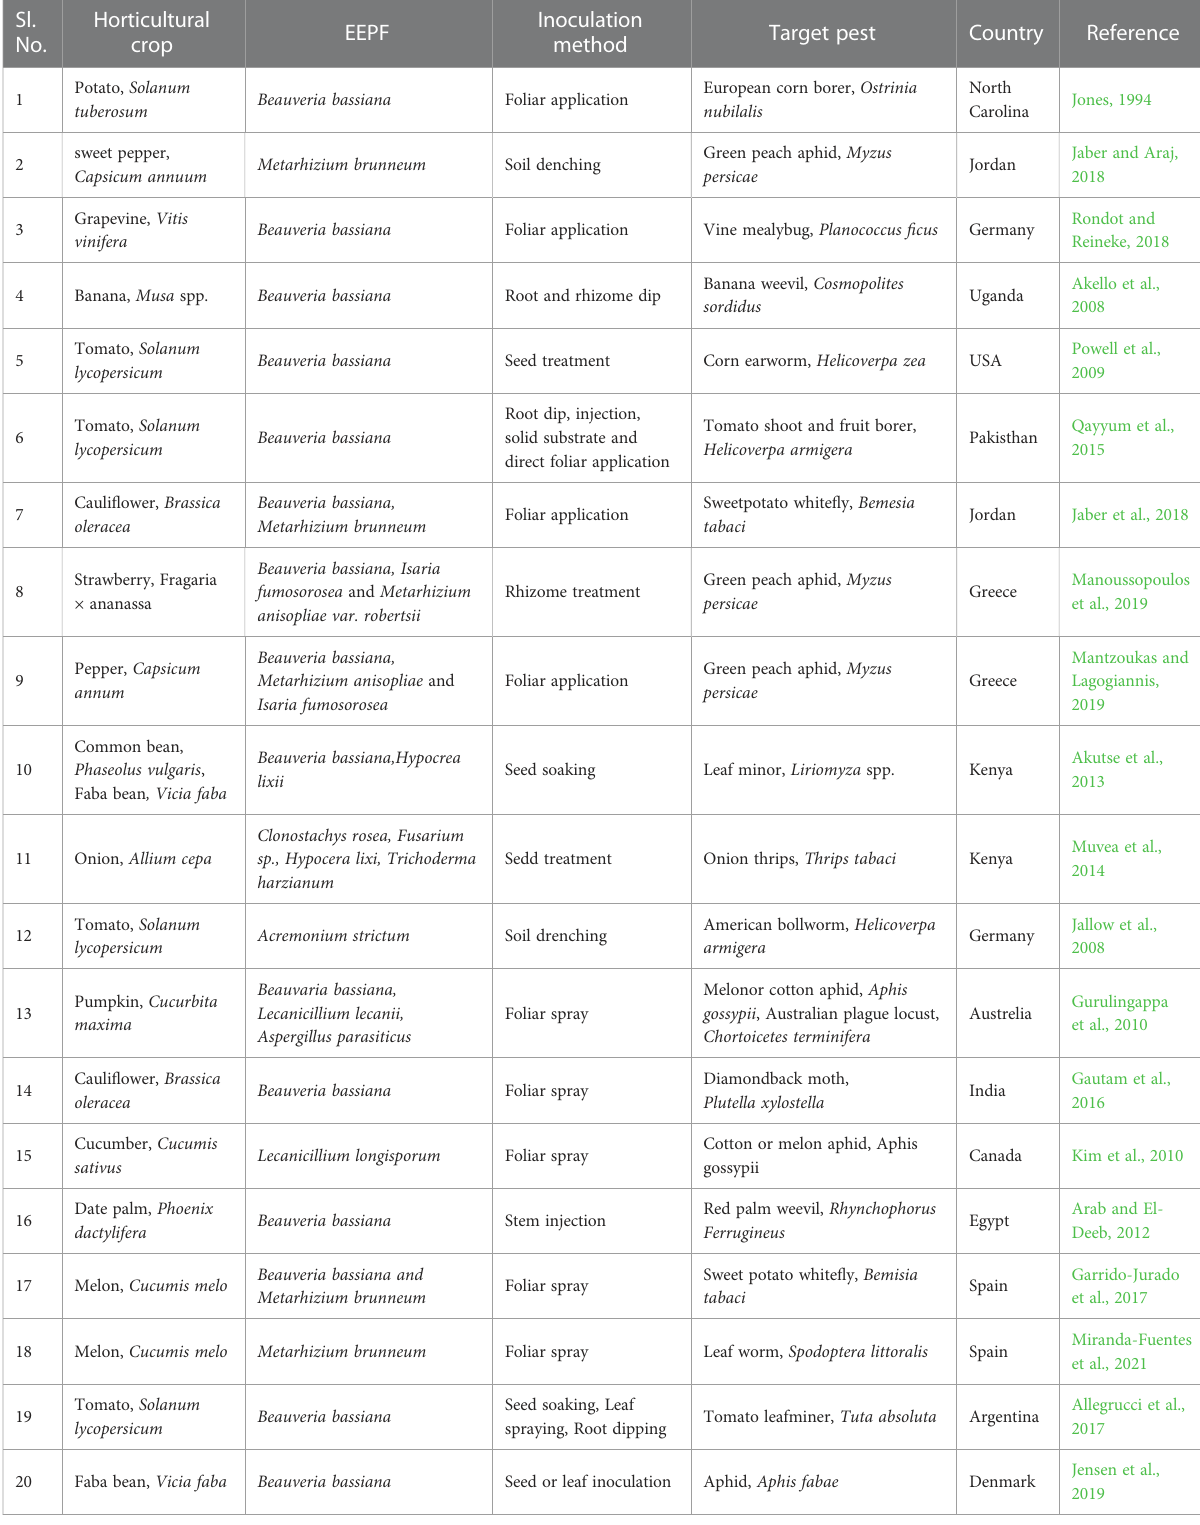
TABLE 2 Successful cases of arti fi cial plant inoculation with endophytic EPF in horticultural crops against herbivore.